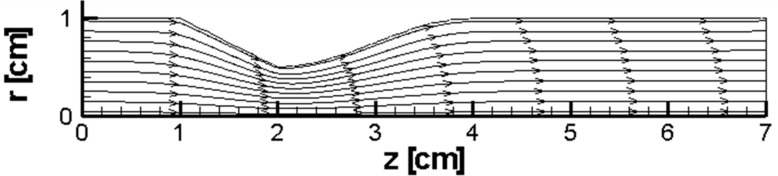
Streamlines for the case without Joule heating at t = 0.5 s, Lvessel = 7 cm, Rvessel = 1 cm and fifty percent stenosis.